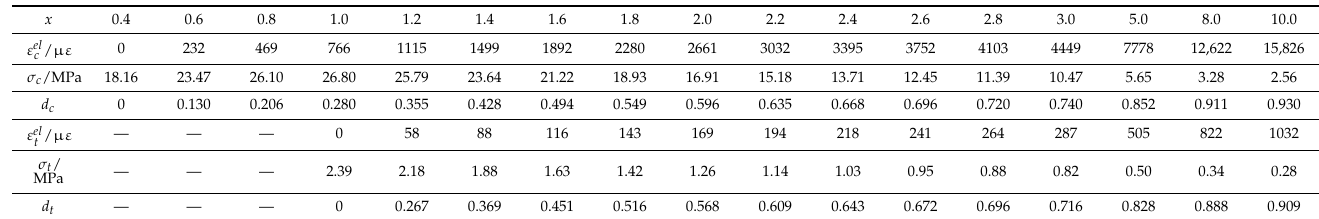
Table 1. Input parameters for the concrete damage model in